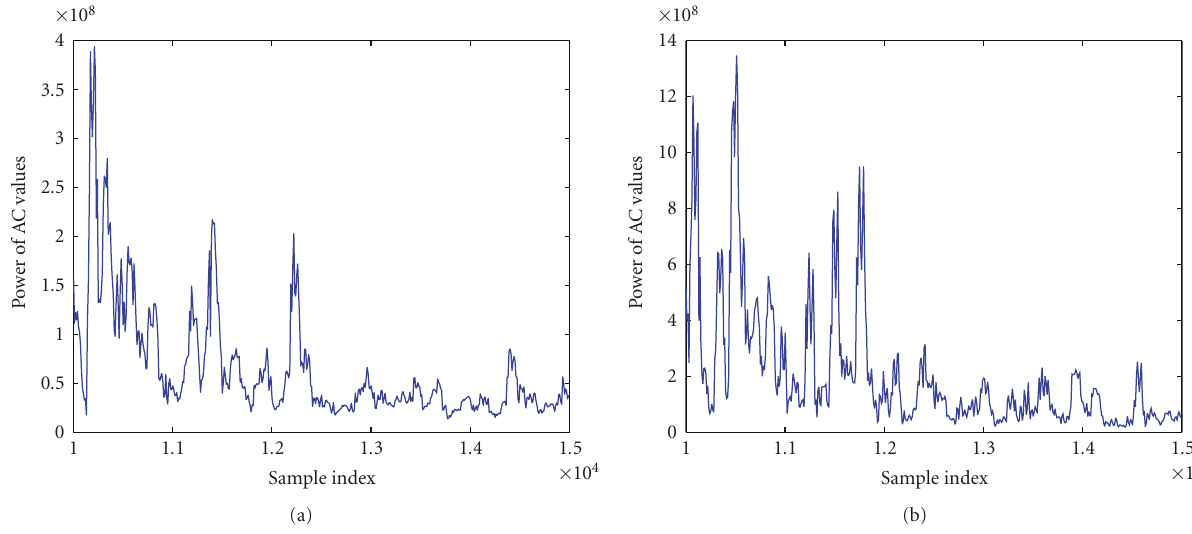
Figure 8: Power of AC values using soft-max-based information integration and DCT. (a) No target (b) With target in the field.